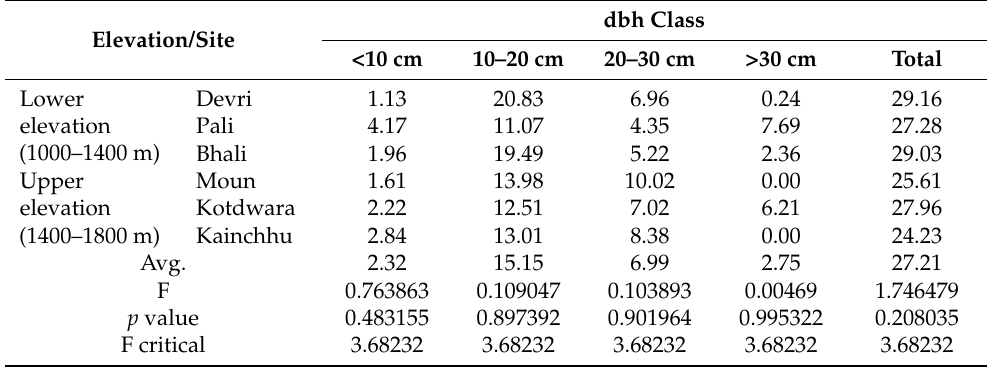
Table 6. Carbon stock (Mg ha − 1 ) in tree biomass of G. oppositifolia -based traditional agroforestry system at two elevations.